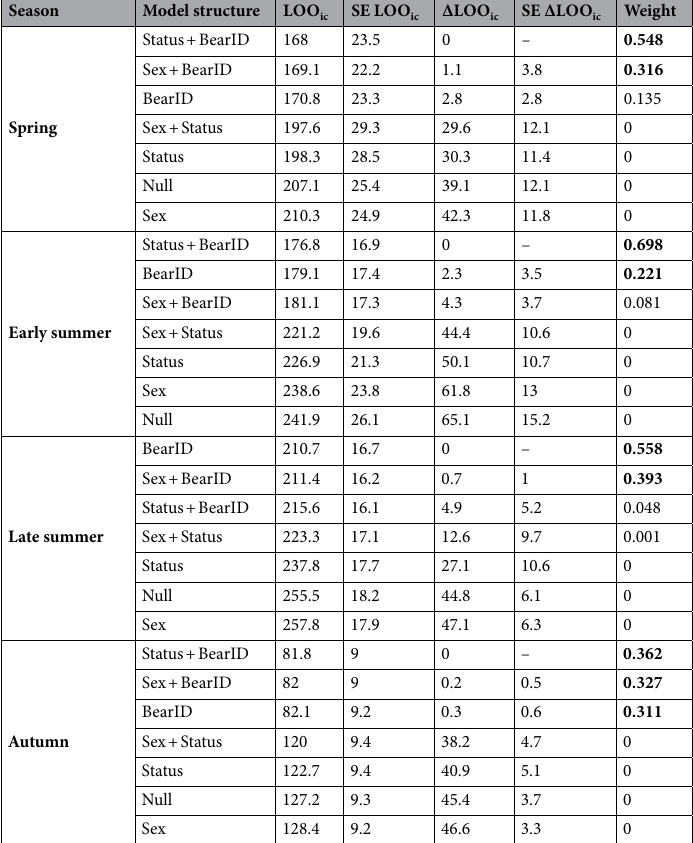
Key food category